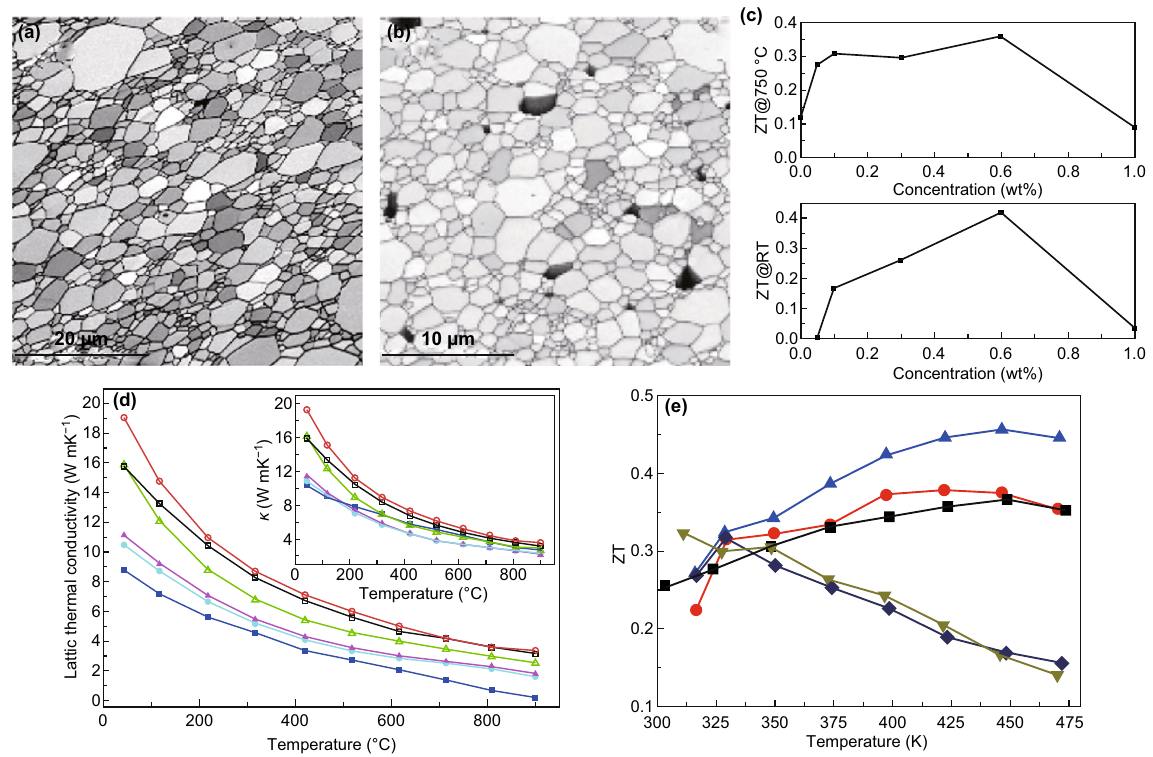
Fig. 9 EBSD analysis of lanthanum strontium titanium oxide sample, and graphene/lanthanum strontium titanium oxide. a Band contrast image of a pure lanthanum strontium titanium oxide sample; b band contrast image of 0.1 wt % graphene/lanthanum strontium titanium oxide. c ZT at room temperature and at 750 °C as a function of the graphene concentration. Reproduced with permission from Ref. [187]. Copyright 2015, American Chemical Society. d Lattice thermal conductivity and (inset) total thermal conductivity of the Al-doped ZnO and AZO/rGO samples. Reproduced with permission from Ref. [188]. Copyright 2015, American Chemical Society. e Thermoelectric properties of the Bi 2 Te 3 /GQDs samples with different GQD contents. Reproduced with permission from Ref. [189]. Copyright 2017, American Chemical